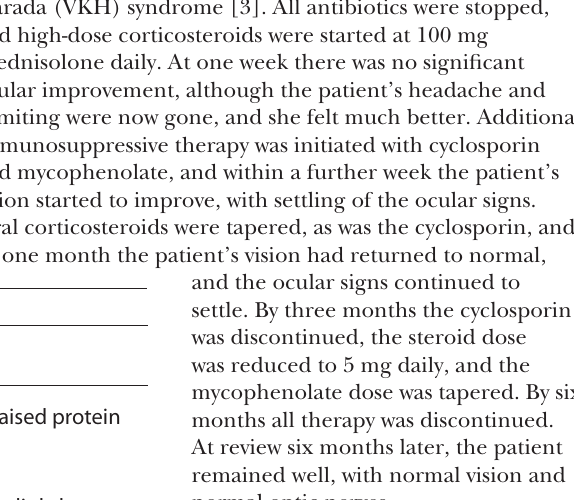
Table 3. Non-Infectious Causes of Abnormal CSF Category